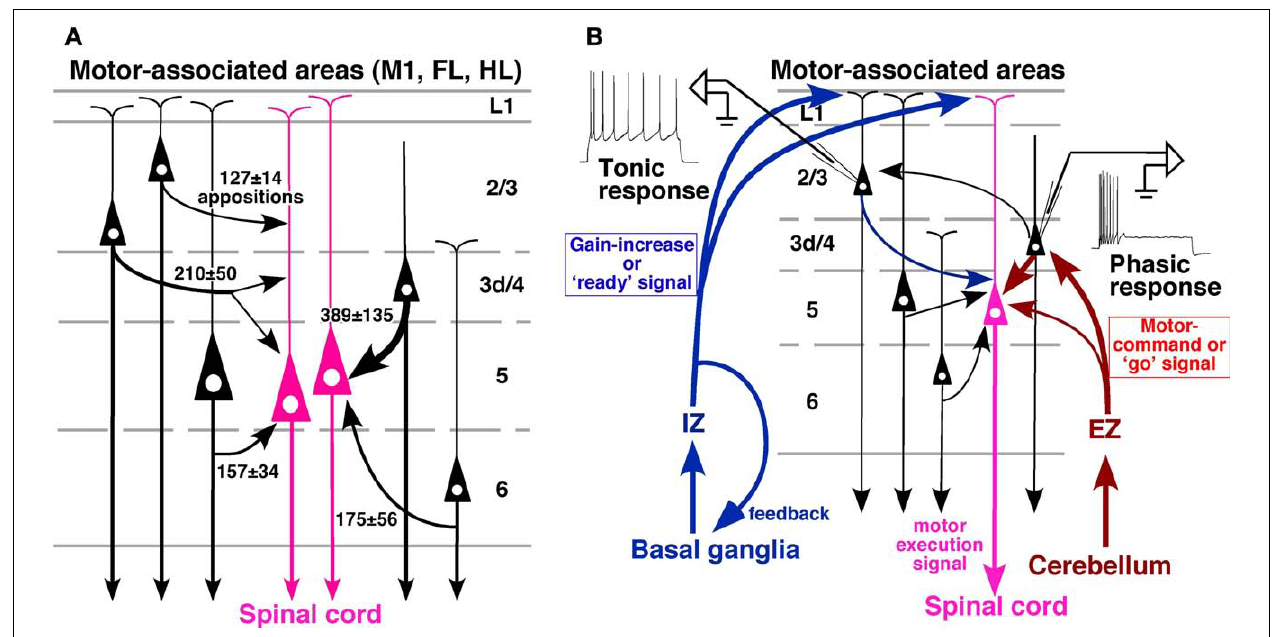
FIGURE 6 | Summary of local excitatory inputs to CSNs and hypothesized circuit for motor control. (A) Although lower L2/3 pyramidal neurons send a considerable number of apposed boutons to CSNs, the strongest inputs are derived from L3d/L4 star-pyramidal neurons.The